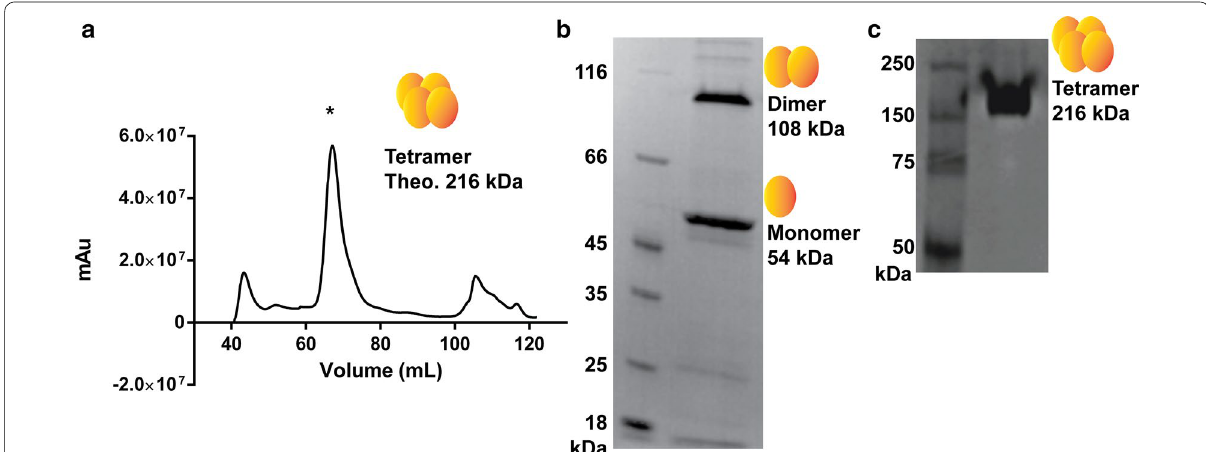
Fig. 1 Purification and oligomerization behavior of a recombinant XylA from B. cenocepacia . a Size exclusion chromatogram obtained from Superdex 200 revealed a major peak. b Two major bands are observed on SDS-PAGE after size exclusion chromatography, revealing molecular sizes consistent with the monomer (ca. 54 kDa) and dimer (ca. 108 kDa) of His 6 XylA fusion. c Native 4–20% gradient PAGE gel shows a single protein band of ca. 216 kDa, when all His 6 XylA-containing fractions were pooled in a single sample. mAu, milli absorbance unit. * XylA containing